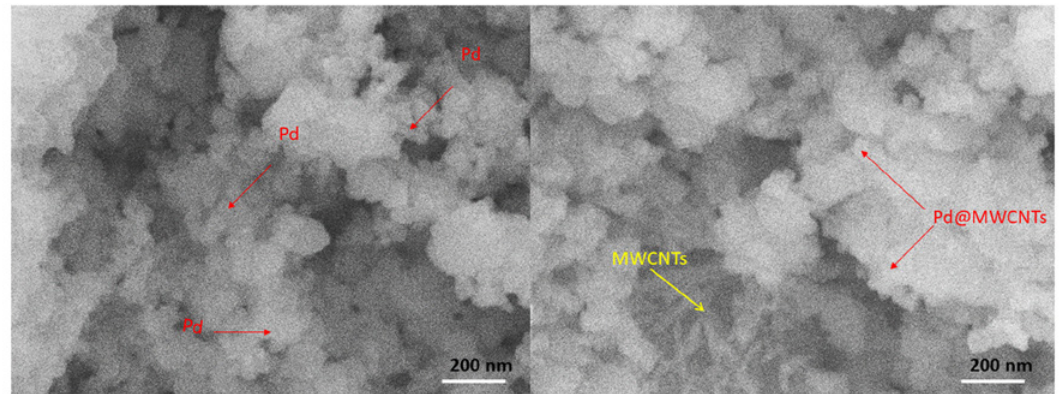
Fig. 2. SEM images with two different magnifications of Pd (left) and Pd supported MWCNTs